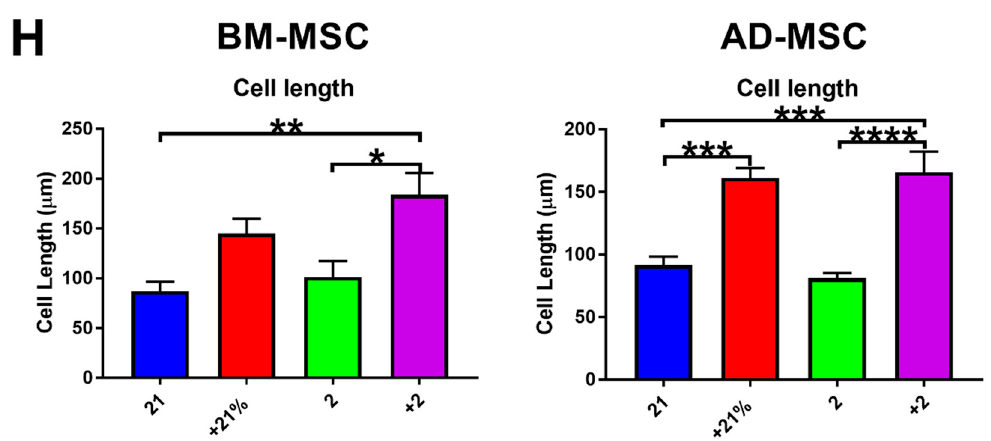
Figure 2. Functional characteristics of preconditioned MSCs. ( A ) Metabolic activity of BM-MSCs significantly increased under hypoxia, while AD-MSCs had no change. ( B ) Proliferative capacity of BM-MSCs was decreased under hypoxia, while AD-MSCs remained unchanged. ( C ) BM-MSCs exhibited increased clonogenic capacity under Cytomix-hypoxia treatment ( p < 0.05), while the clonogenic capacity of AD-MSCs were unchanged. ( D ) Representative images of colony forming unit assay for each experimental grouped stained with Giemsa. ( E ) Viability was decreased in preconditioned AD-MSCs compared to that in their BM counterparts. ( F , G ) Cytomix treatment induced morphological changes in both BM-MSCs and AD-MSCs, including representative images of length measurements. MSCs treated with Cytomix-normoxia and Cytomix-hypoxia appeared more elongated compared to normoxia and hypoxia groups. ( H ) Cell length measurements from fluorescence imaging. The addition of Cytomix made MSCs become more elongated and spindle-like. * p < 0.05, ** p < 0.01, *** p < 0.001, **** p < 0.0001. All scale bars represent 250 µ M. Viable cells were stained with calcein AM; dead cells were stained with ethidium homodimer-1; and nuclei of all cells were stained with Hoechst.